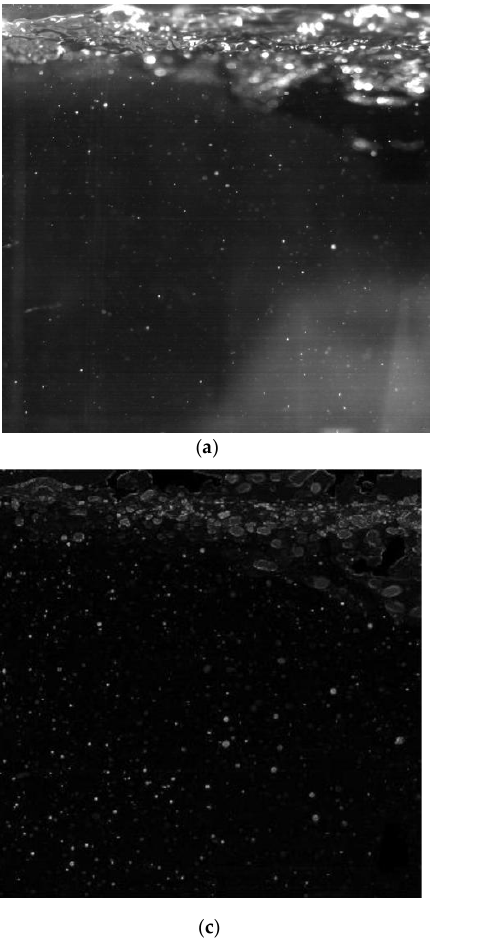
Figure 4. Image processing process. ( a ) Original image, ( b ) nonlinear smoothing filtering, ( c ) watershed image after segmentation, ( d ) binarization image.